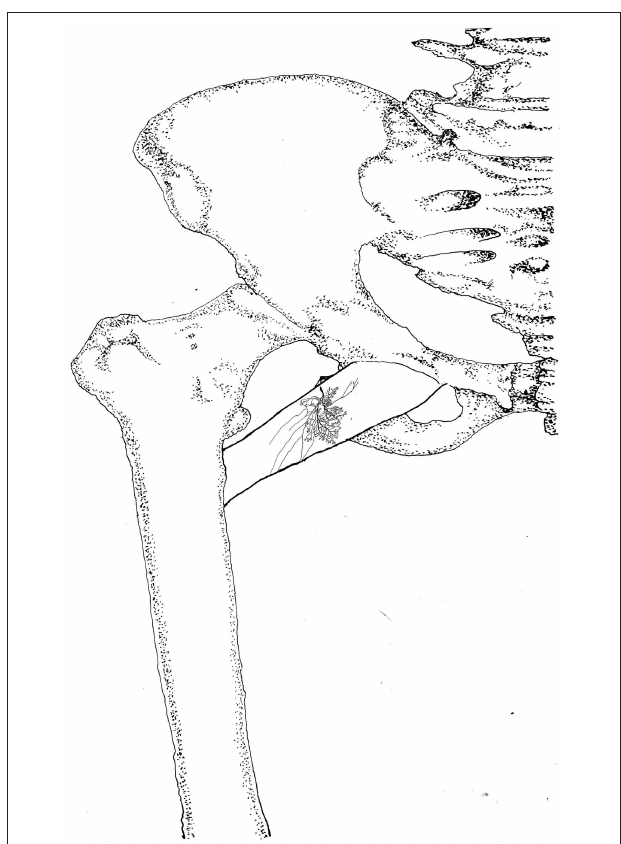
FIGURE 10 | Three dimensional pattern of intramuscular nerve distribution in the pectineus (right, superficial side; BFN, branch of the femoral